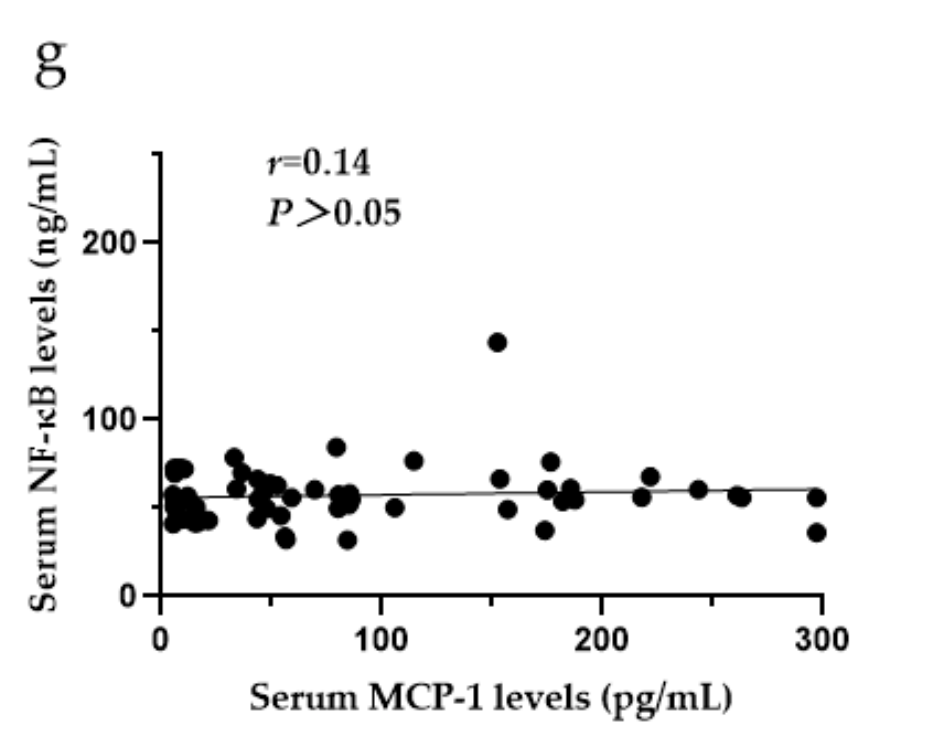
Figure 9. ( a ) Correlation analysis of ERK1/2 and NF- κ B in SF ( n = 60); ( b ) correlation analysis of CXCR4 and ERK1/2; ( c ) correlation analysis of CXCR4 and NF- κ B; ( d ) correlation analysis of SDF-1 and ERK1/2; ( e ) correlation analysis of SDF-1 and NF- κ B; ( f ) correlation analysis of MCP-1 and ERK1/2; ( g ) correlation analysis of MCP-1 and NF- κ B. CXCR4: C-X-C motif chemokine receptor 4; SDF-1: stromal cell-derived factor-1; MCP-1: monocyte chemoattractant protein-1; ERK1/2: extracellular signal-regulated kinase 1/2; NF- κ B: nuclear factor- κ B.